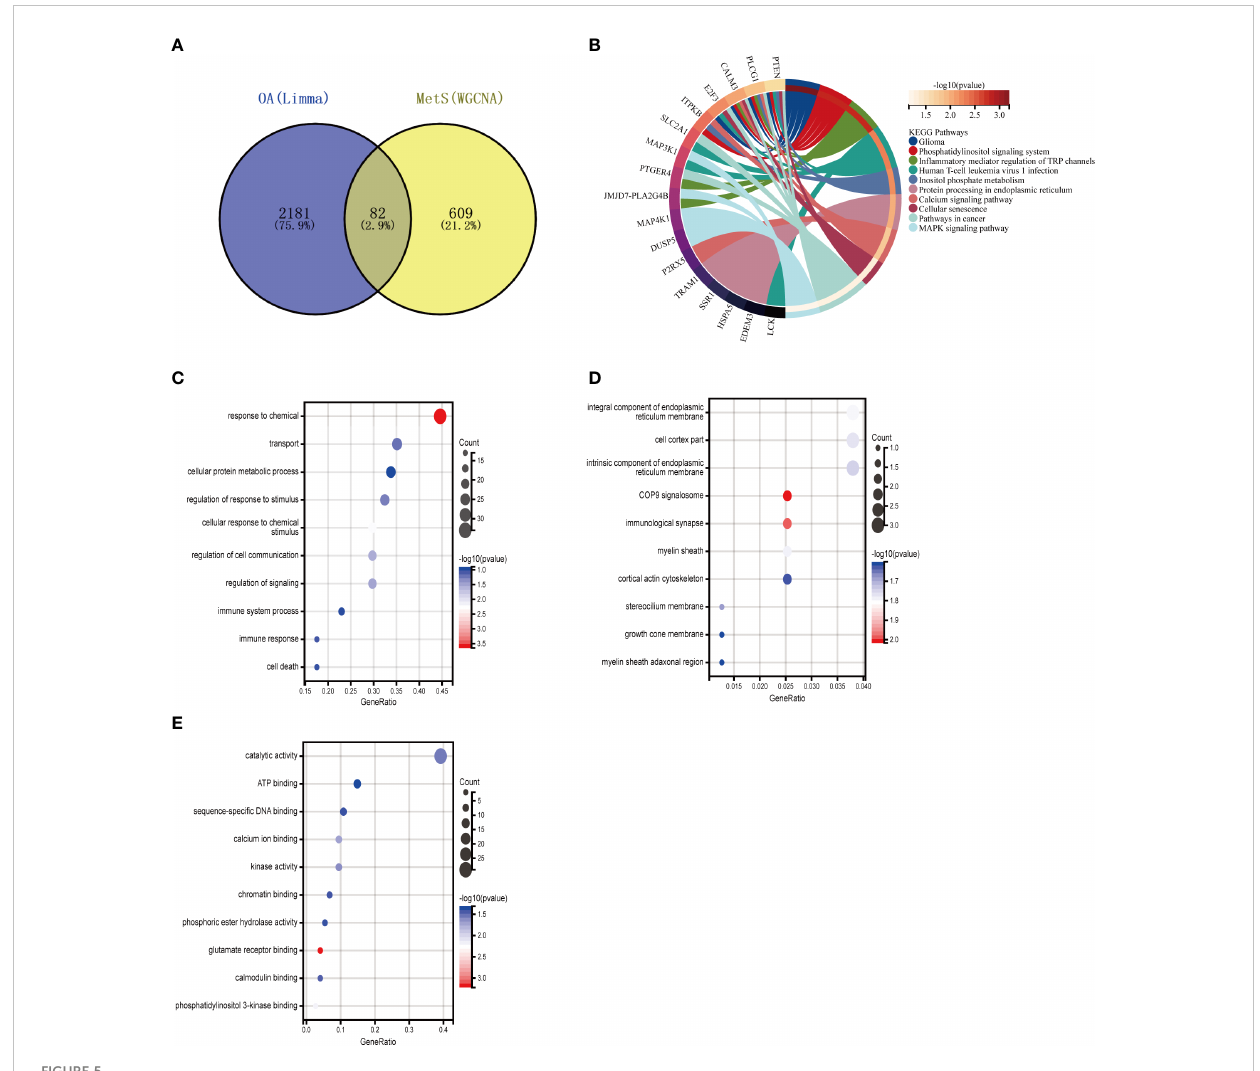
FIGURE 5 Enrichment analysis of common genes from OA with MetS. (A) Venn diagram shows that 82 common genes are identi fi ed from the intersection of genes in OA using Limma and MetS using WGCNA. (B) KEGG analysis of 82 common genes. (C – E) GO analysis (hiological process, cellular component, and molecular function) of 82 common genes. OA. Osteoarthritis: MetS, Metabolic syndrome, WGCNA, weighted gene co-expression network